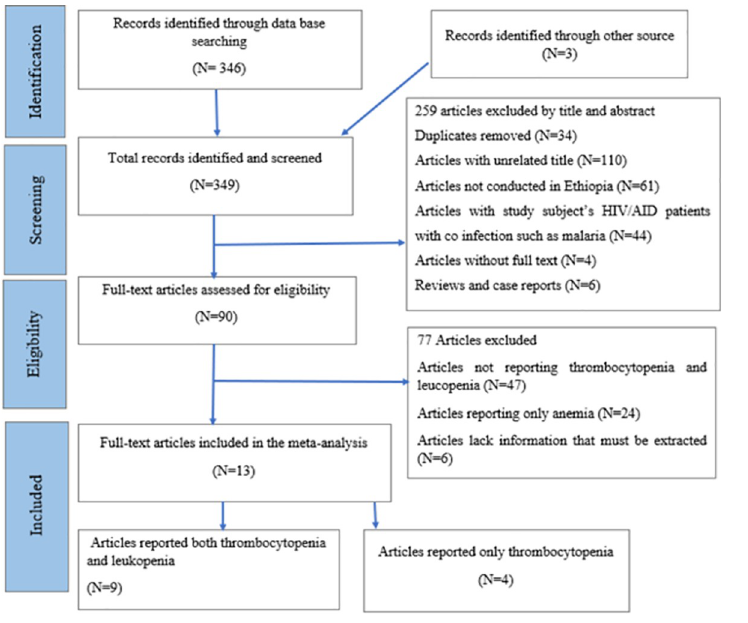
Fig 1. Flow chart of study selection process.